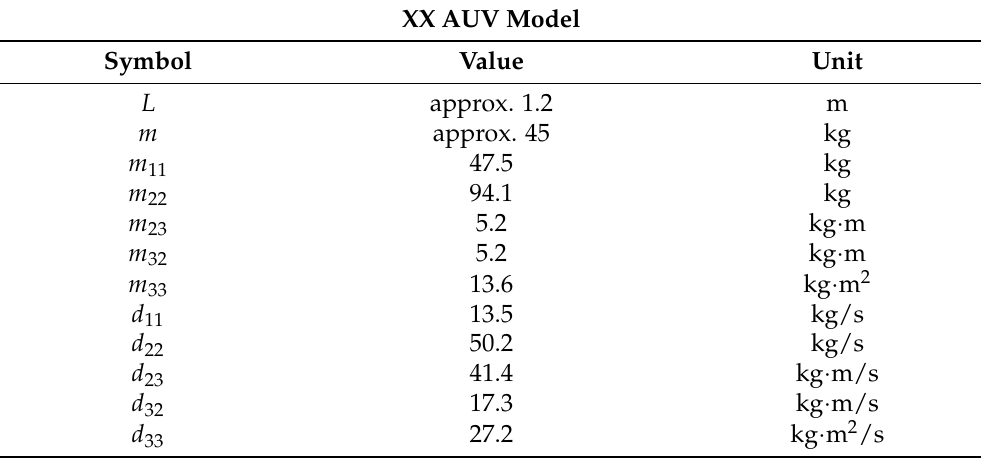
Table 2. Parameters XX AUV